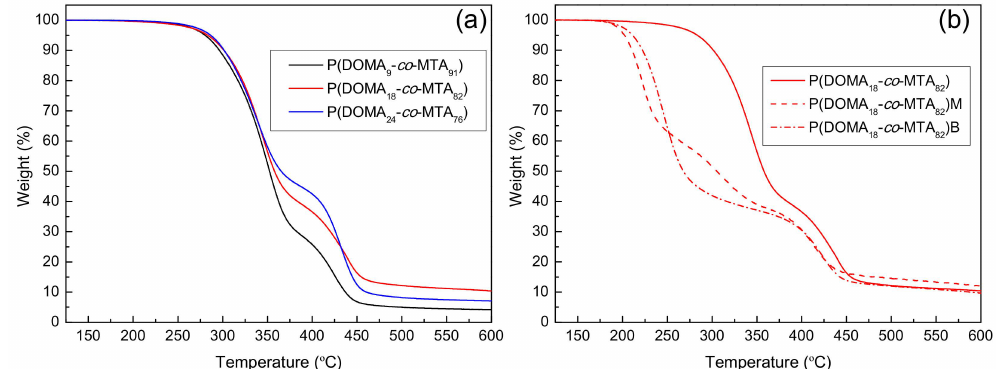
Figure 3. TGA analysis of ( a ) unquaternized P(DOMA x - co -MTA y ) copolymers and ( b ) influence of the quaternization of P(DOMA 18 - co -MTA 82 ) on the thermogravimetric